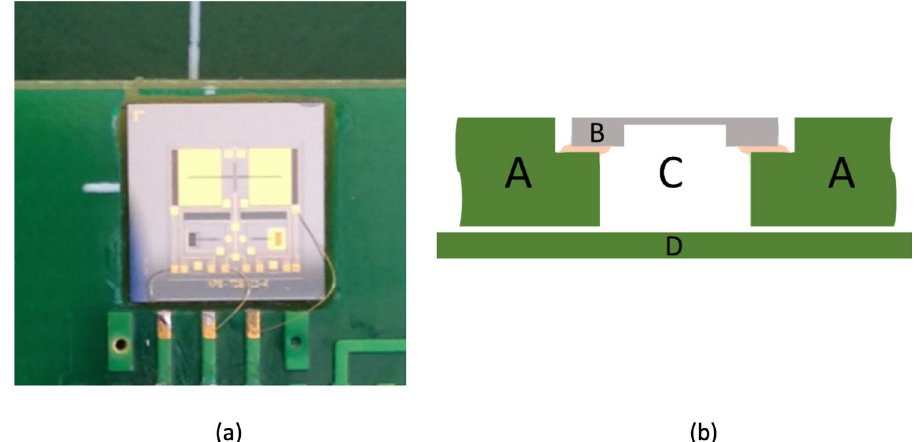
Figure 2. Sensor assembly on a pressed circuit board (PCB). Topview picture of the sensor die glued and wirebonded to the circuit board ( a ). Sideview schematic diagram of the sensor assembly ( b ): the sensor die (B) was glued on a top PCB board (A), over a through-hole (C); a separate PCB board piece (D) was attached to the bottom side configuring a back air cavity for the sensor. The space left between the two circuit boards (A and D) in the schematic is intended to convey the idea of imperfect sealing and physical link (air and pressure) between the cavity and the exterior medium.